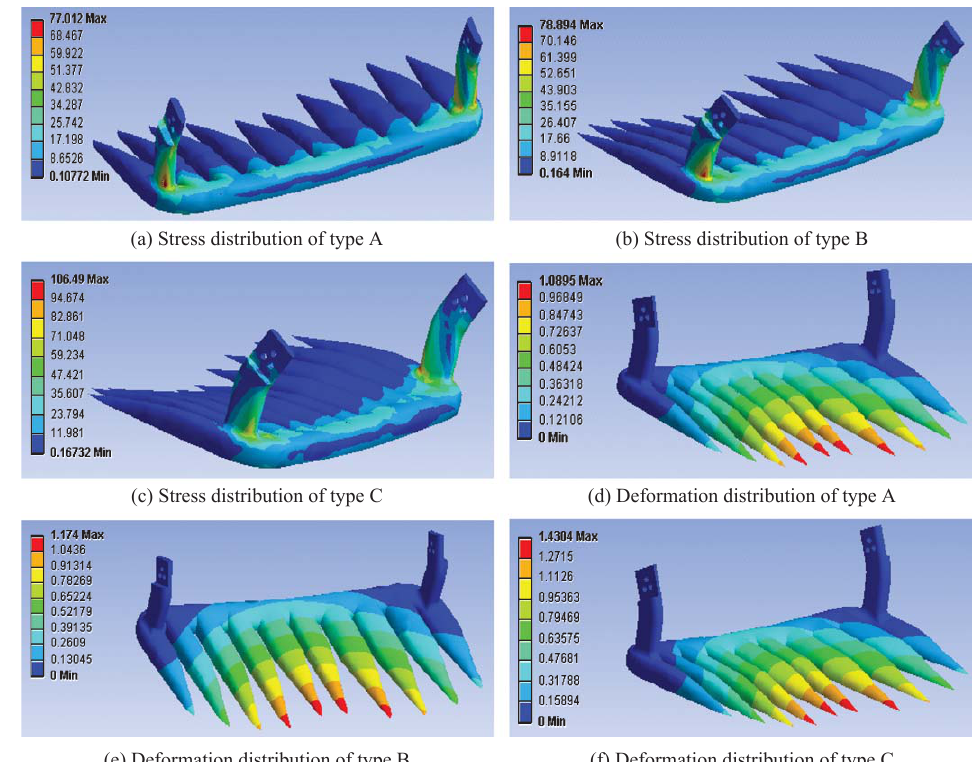
Fig. 9. Tilt angle 25 ◦ digging shovel’s finite element analysis